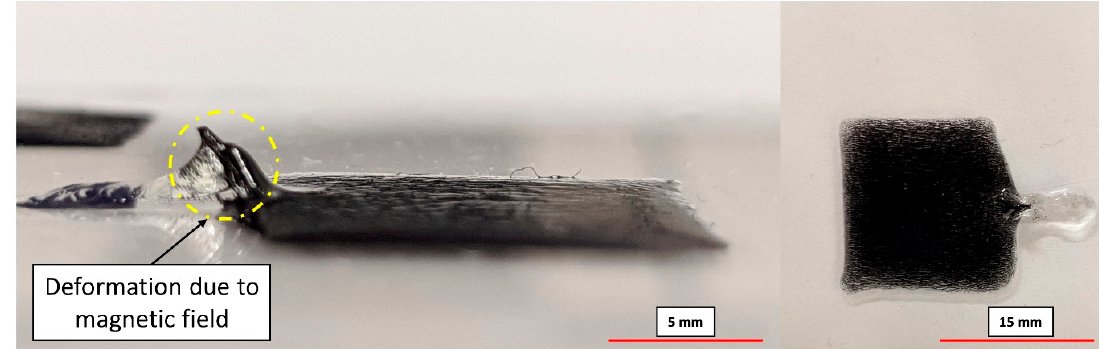
Figure 12. 3D printed magnetic composite with observed deformations caused by the magnetic field (deformation indicated by circles).